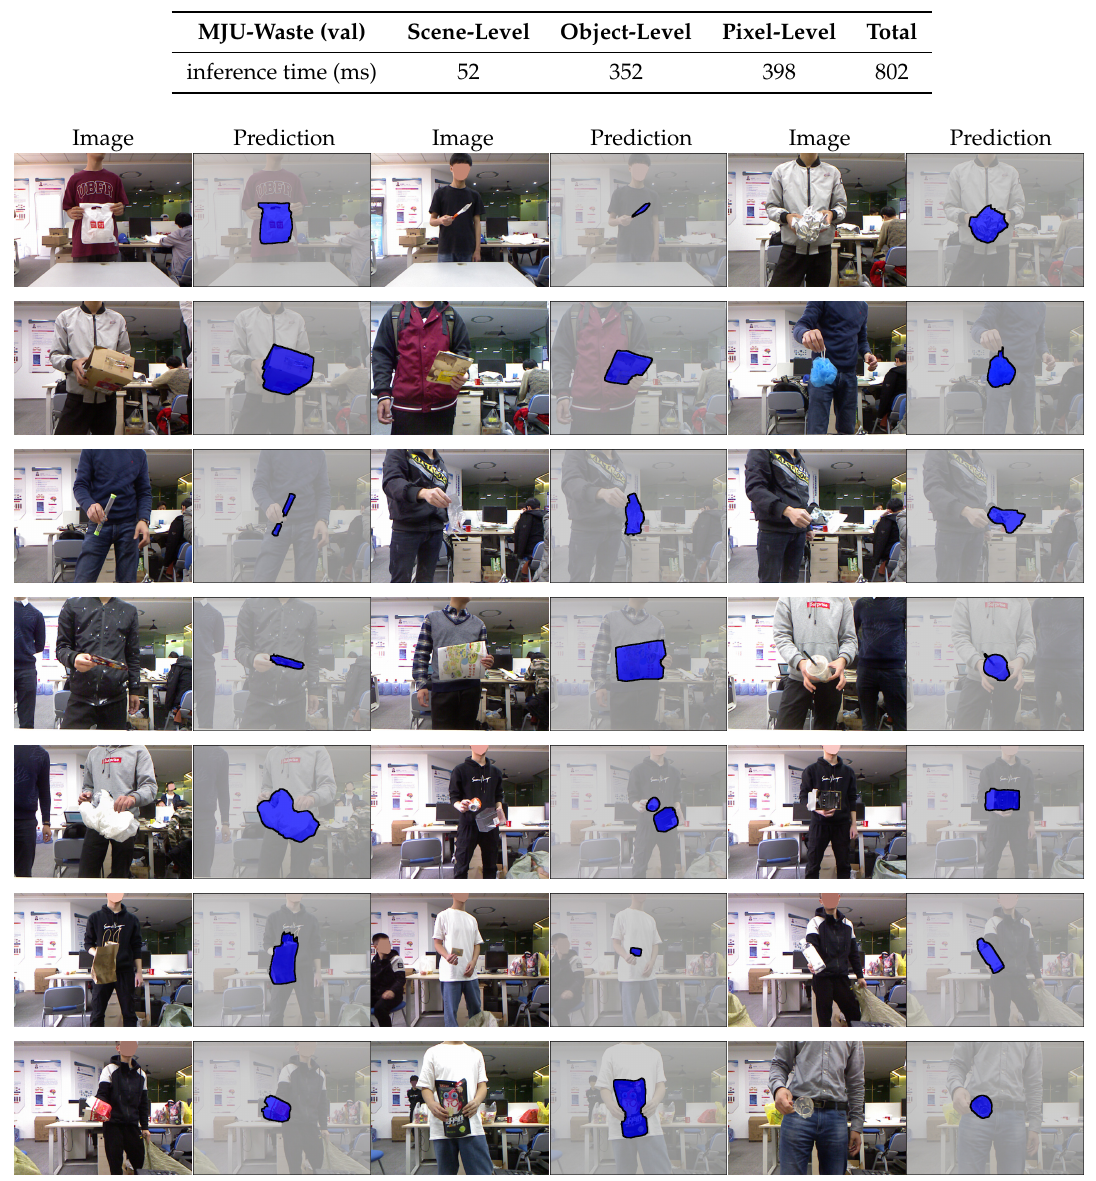
Figure 7. Segmentation results on MJU-Waste (test). Method is DeepLabv3-ML